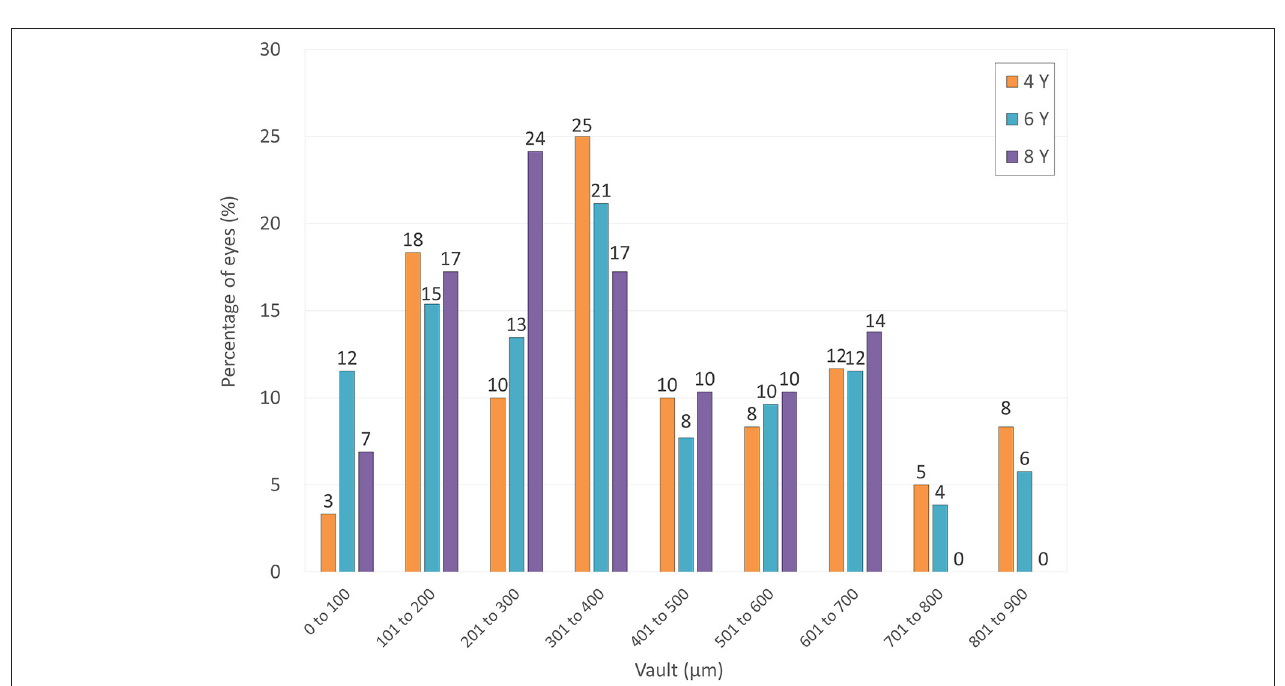
Table 3 summarizes the long-term visual and refractive outcomes of conventional ICL implantation without a central port, spanning 10 years or more, and EVO-ICL implantation,